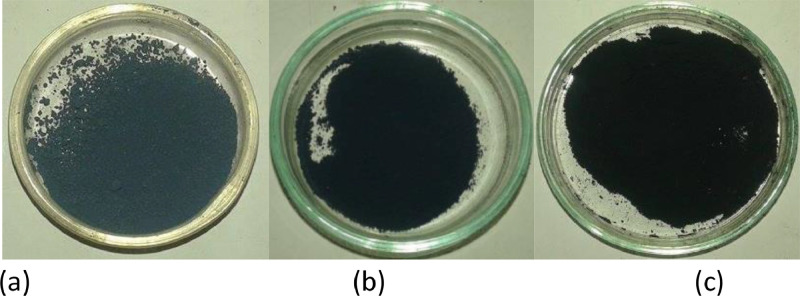
Synthesized TiO2/Fe3O4 catalysts (a) 80/20; (b) 50/50; (c) 20/80.